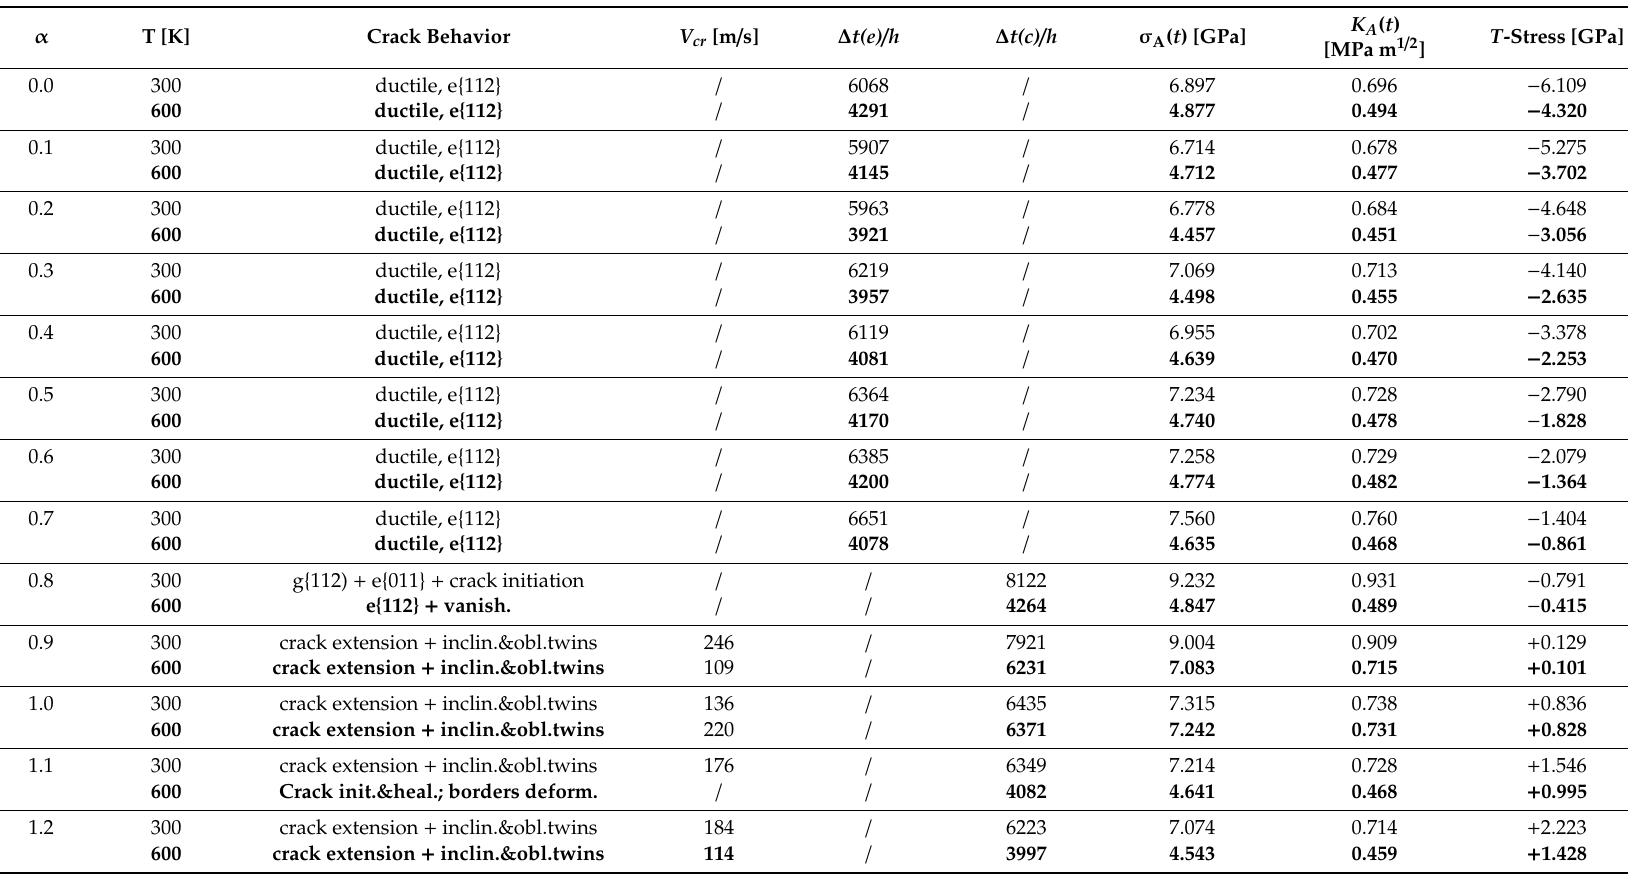
Table 1. The ductile vs. brittle behavior at temperatures of 300 K and 600 K ( bold ) and di ff erent biaxiality ratios α = σ B / σ A ; ∆ t ≡ ∆ t (e) is the loading time when the first complete dislocation emission < 111 > {112} is monitored (i.e., when U10 / b = 1); ∆ t ≡ ∆ t(c ) denotes the situation when crack initiation or extension is detected; V cr is the crack velocity; T -stress is calculated from Equation